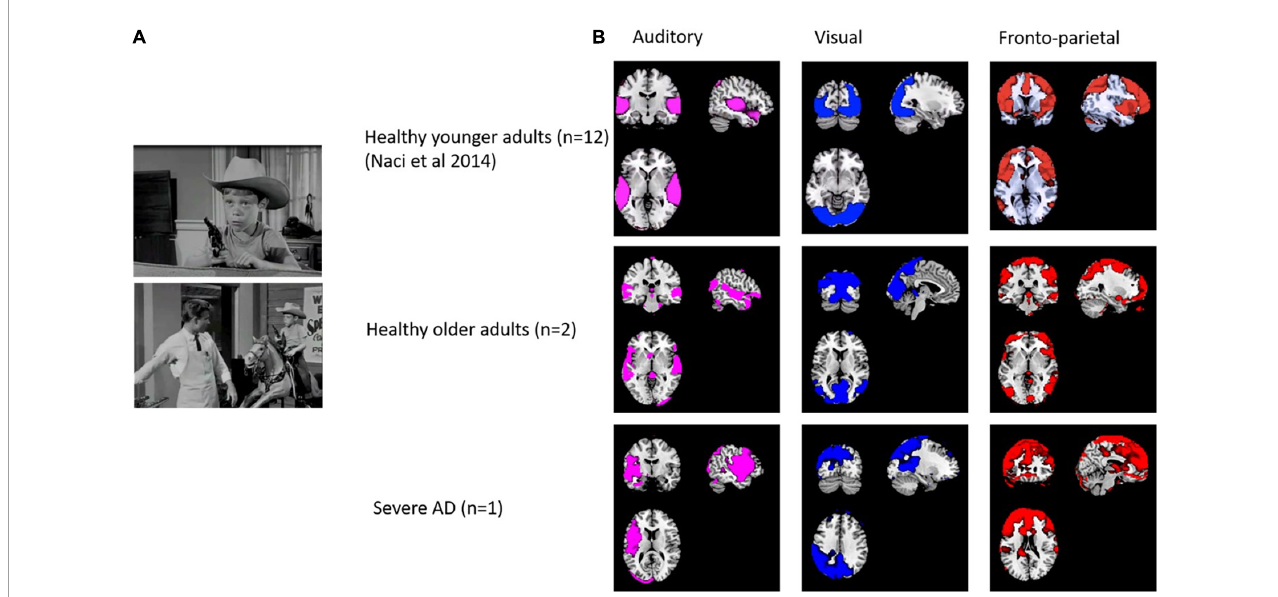
FIGURE4 (A) Stills from the edited movie “Bang! You’re dead!”. (B) Spatial comparison of auditory, visual, auditory and fronto-parietal components in 12 healthy adults (from Naci et al., 2014), older adults ( n = 2) and a patient with severe